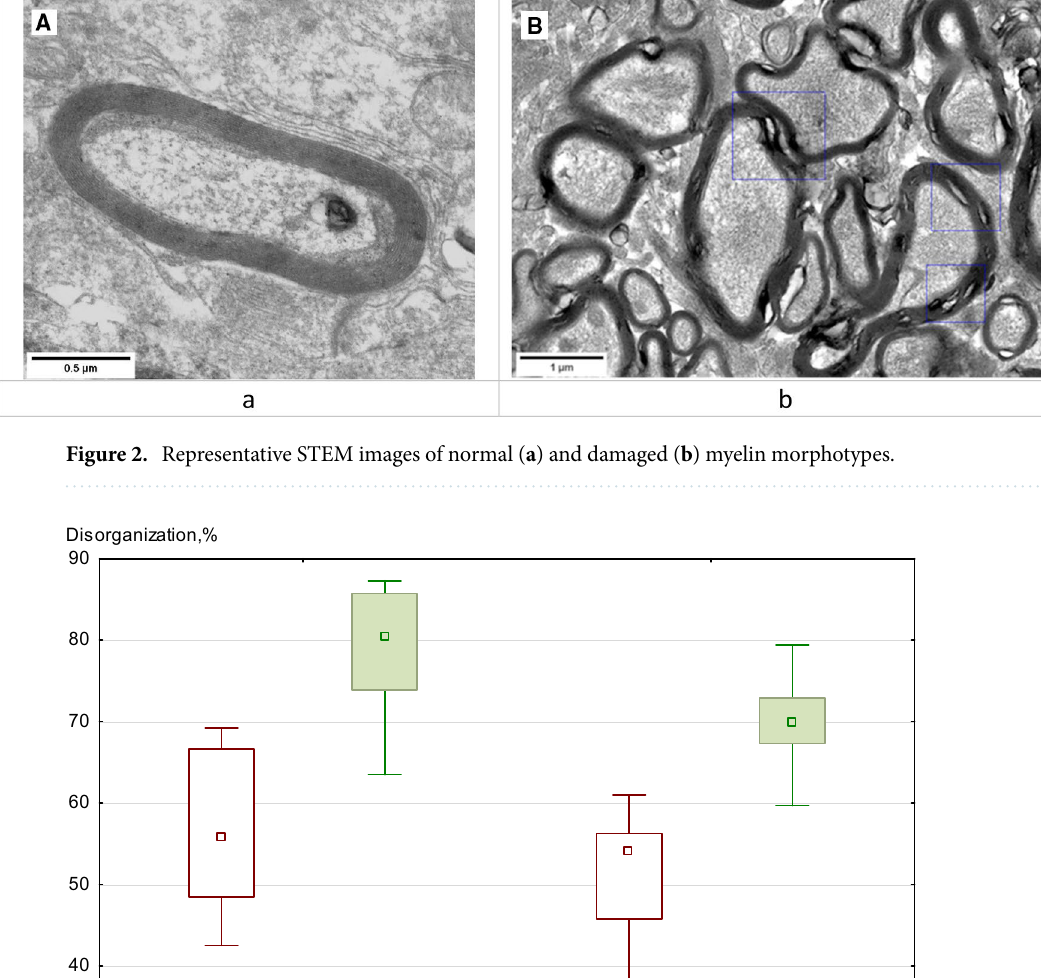
vesicular, vesicular, vesicular swollen, and swollen. Observations made based on the analysis of micrographs of neuronal mitochondria in both groups confirm the presence of these five morphotypes (Figure 5). The images show signs of membrane double contour damage, destruction of the cristae, and clearing of the mitochondrial matrix. Representative STEM micrographs are shown in Figure 5. All mitochondria found in the ultrathin section were classified by two independent researchers based on inner membrane topology, and the proportion of each mitochondrial morphotype was estimated (Figure 6). The two-way ANOVA of collected data proved the differences in the distribution of mitochondrial morphotypes observed and described above, both depending on the group and on the area of the brain (FGroup(4.20)=28.378, p <0.001; FTissue(4.20)=13.740, p =0.000015). The additional one-way analysis of vari- ance confirmed those differences (Table S1). In the olfactory bulb tissues of the animals exposed to PbO NPs, we observed a decrease in the percentage of normal and vesicular swollen mitochondrial morphotypes of their total number by 26.4% ( p =0.003405, U-test M-U) and 7.1% ( p =0.005341, U-test M-U), respectively, compared with the control group of animals, while the